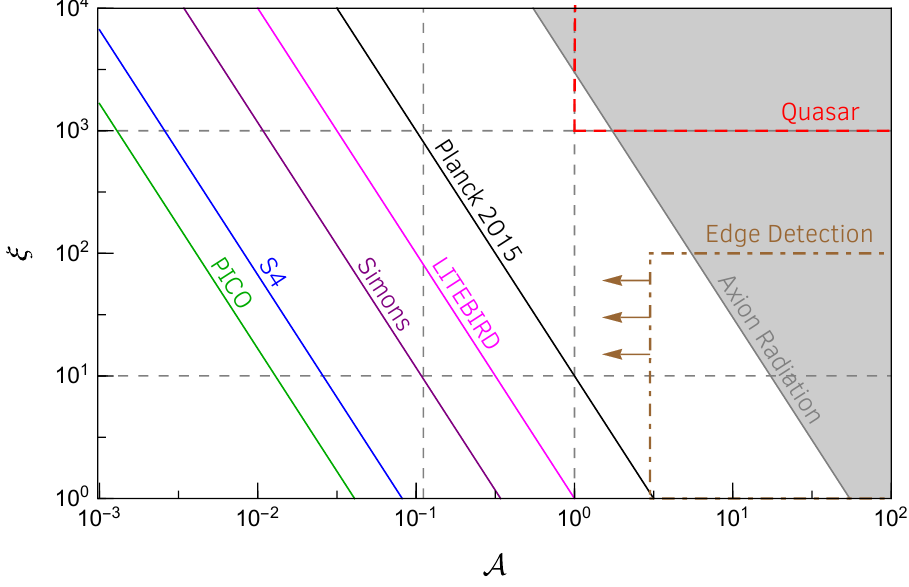
Figure 10 . We show the sensitivity of current and future experiments to the two independent parameters of an axion string network with a photon coupling; the number of axion string per Hub- ble volume ( (cid:24) ) and the strength of the axion string-photon coupling ( A ). The CMB polarization correlation functions provide the best channel for discovery (they put an upper bound on the com- bination (cid:24) A 2 ). The black solid line is the estimated current sensitivity of Planck to this e(cid:11)ect while the magenta, purple, blue and green lines show the sensitivity of future CMB experiments. We take the sensitivity at L = 10 from (cid:12)gure 6 as an indicator. The grey region is the estimated constraint coming from the e(cid:11)ects of axion radiation emitted from the string network, see the discussion around equation (4.20). CMB experiments with good angular resolution and lensed quasar systems provide an opportunity to exploit the quantized nature of our signal. The brown dot-dashed line shows the prospects for edge detection with experiments similar to the Simons observatory (very qualitative). Increasing the accuracy of the polarization rotation angle measurement improves the sensitivity to smaller A and improving the angular resolution improves the sensitivity to higher (cid:24) . The red dashed line shows the prospects for lensed quasar systems (qualitative). Increasing the number of lensed quasars improves the sensitivity to smaller (cid:24) while improving the precision of the measurement of the relative polarization of the quasars improves the sensitivity to smaller A . The gray dashed gridlines mark the regions of parameter space of particular theoretical